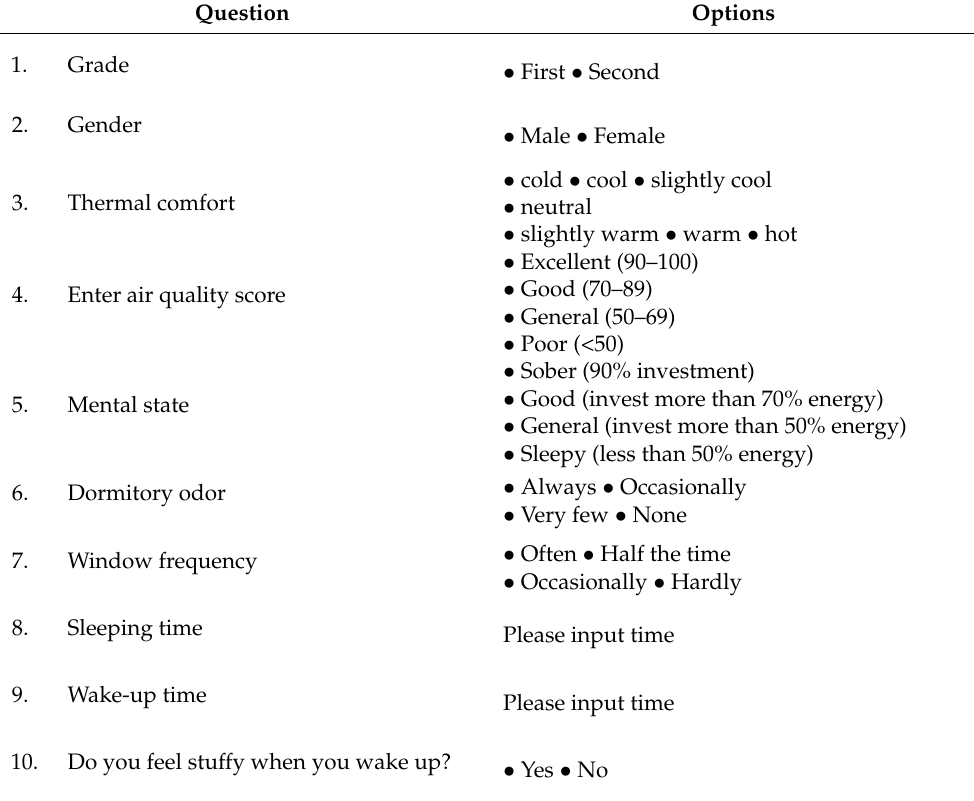
Table 3. Indicators of the questionnaire survey.